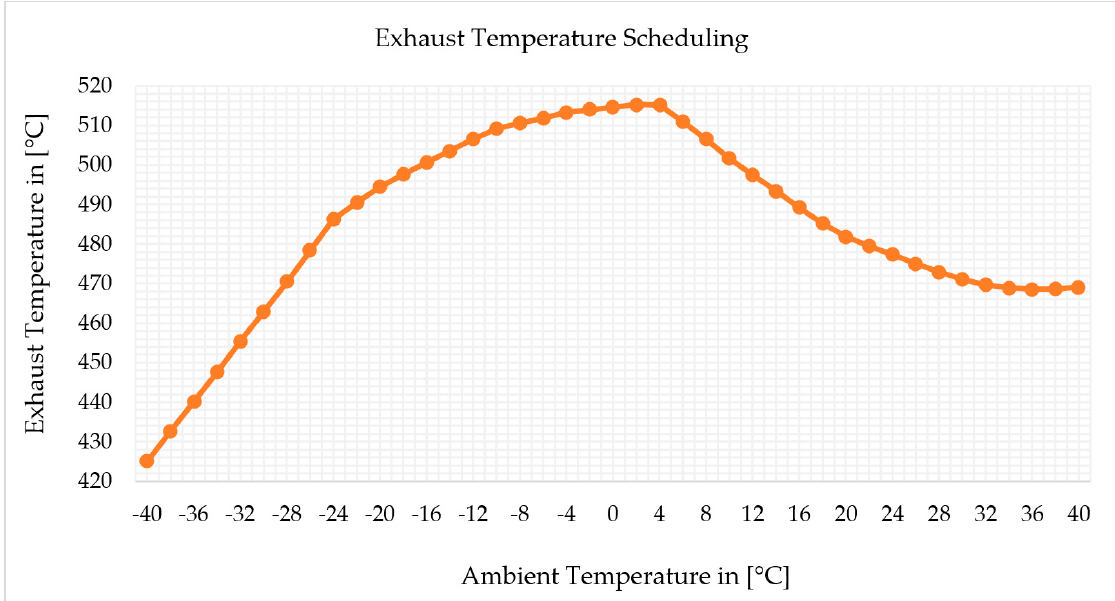
Figure 4. Exhaust temperature scheduling in the simulation .